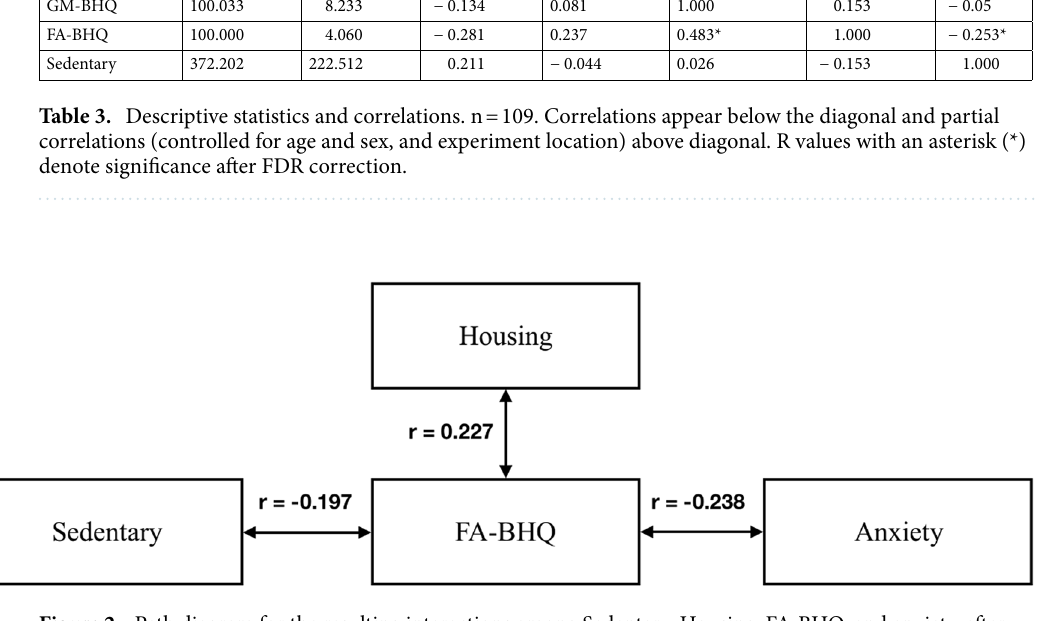
Figure 2. Path diagram for the resulting interactions among Sedentary, Housing, FA-BHQ, and anxiety, after controlling for Age and experiment location. FDR correction was applied using a threshold of 0.05. All pathways shown are